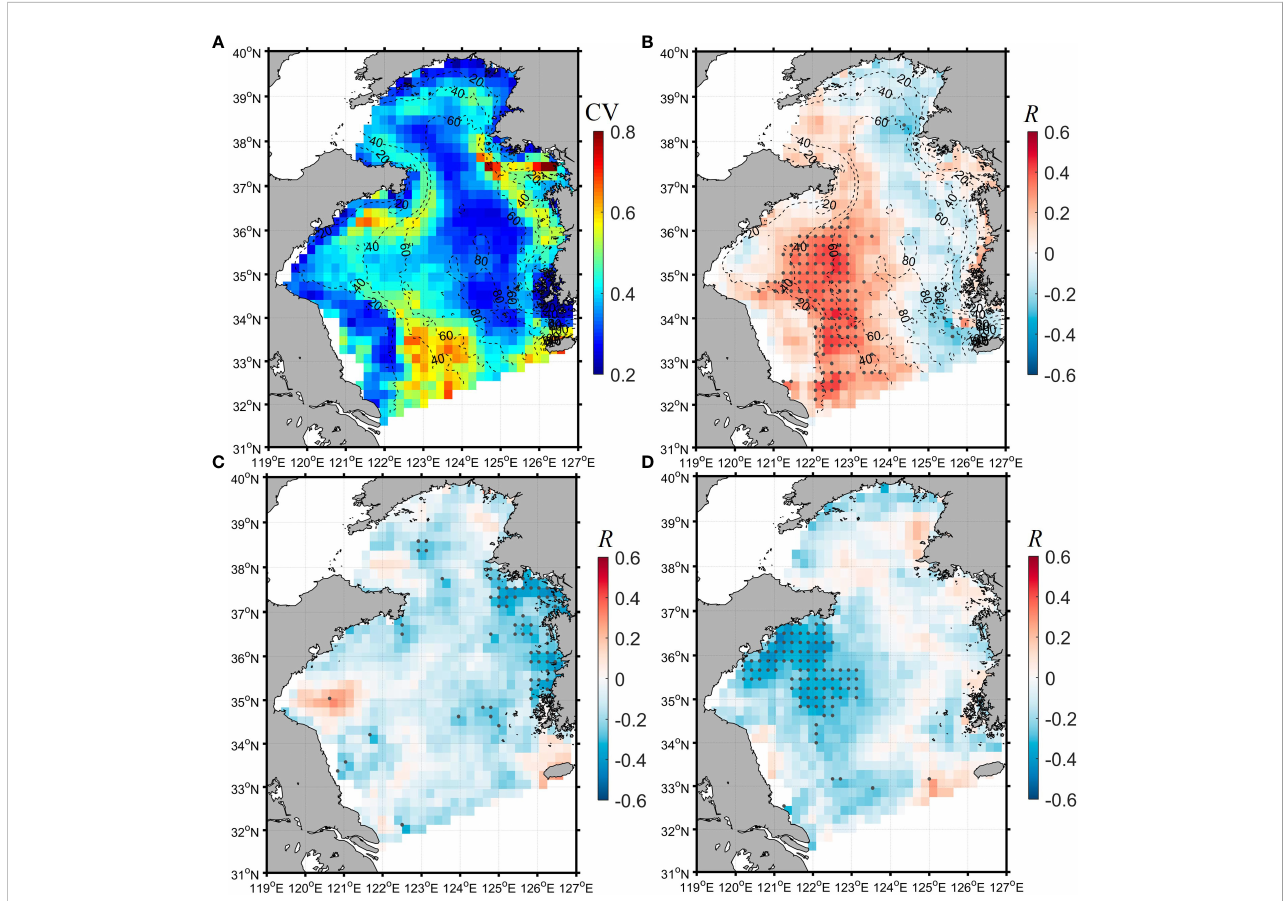
FIGURE 3 (A) The coef fi cient of variation (CV) for the monthly mean Chl-a in summer. (B – D) The correlation coef fi cient R for the monthly wind-Chl-a (B) , SST- Chl-a (C) , and CRD-Chl-a (D) correlation analyses, respectively. The gray dots in (B – D) denote the location of signi fi cant correlation ( P <0.05). The black dash lines in (A, B) are the